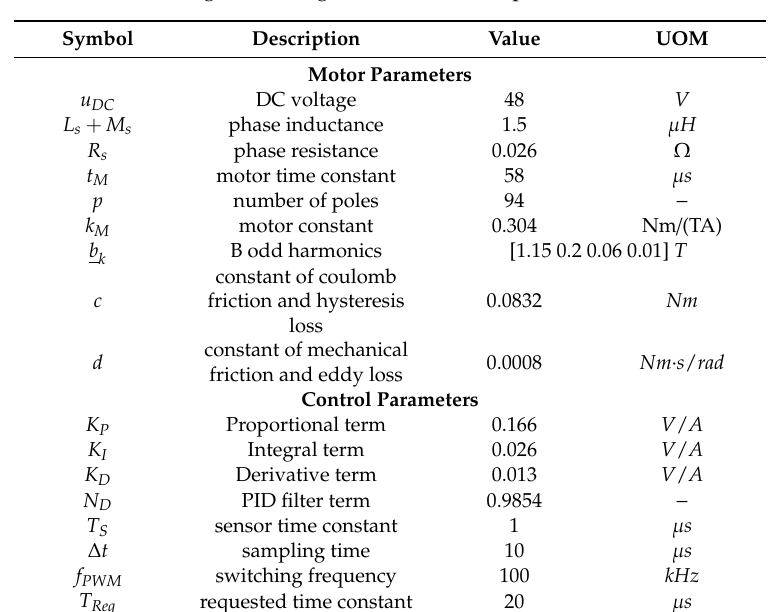
Figure 4. Experimental setup for OTMIC verification [18]. Table 1. Air gab winding wheel-hub motor parameters